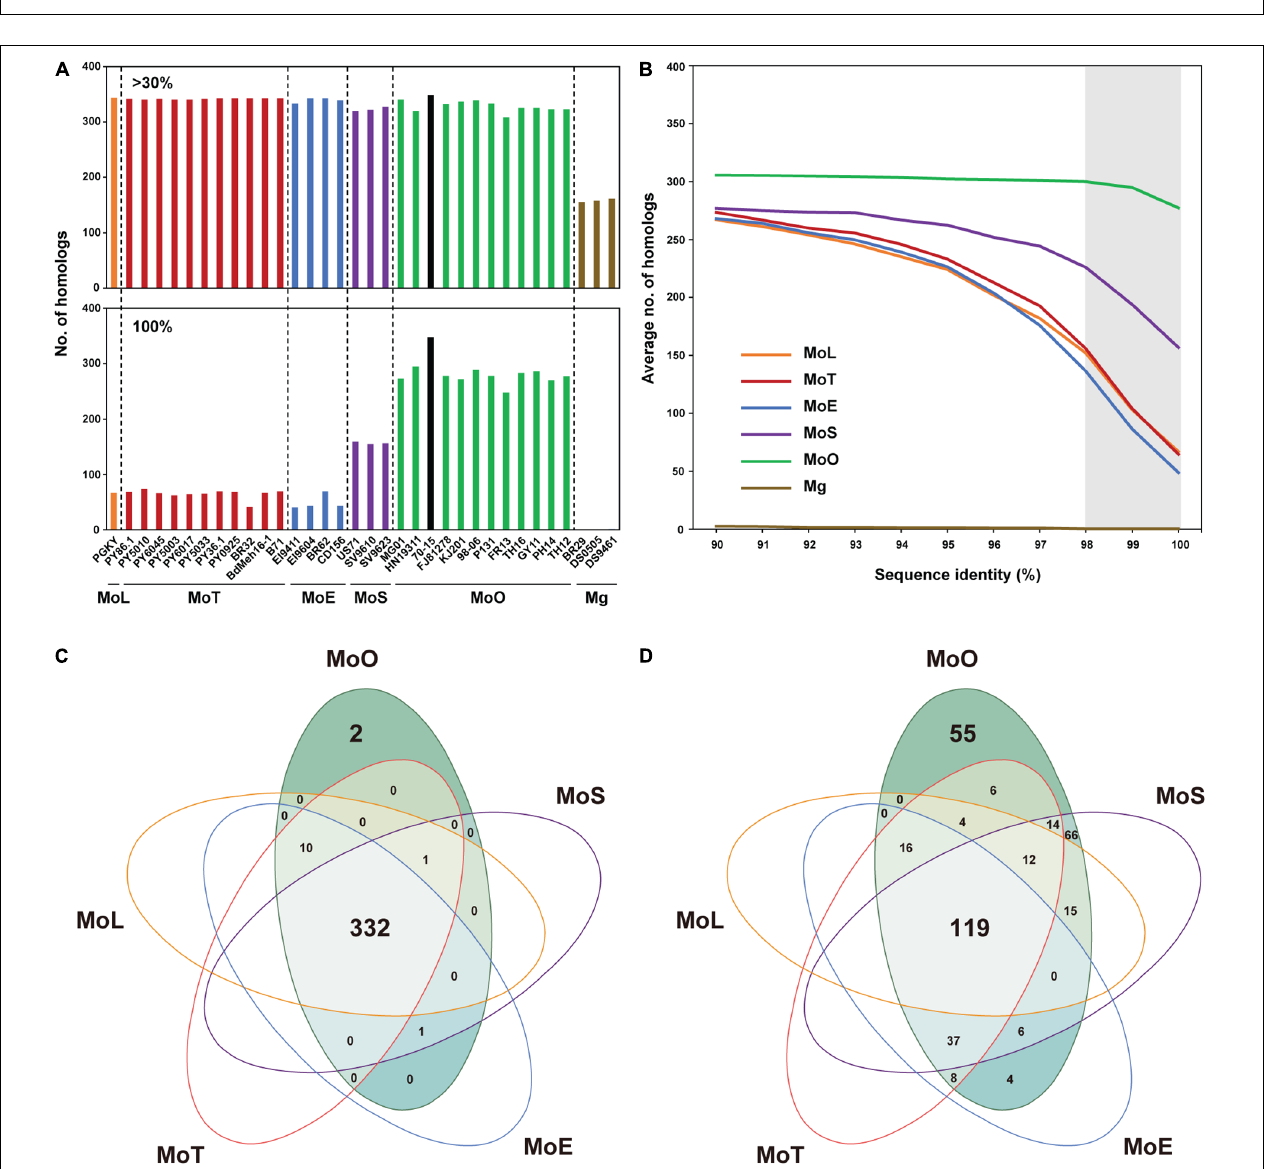
FIGURE 2 | Distribution pattern of the proteins homologous to the 70-15 EFCs. (A) The number of EFC proteins homologous to those encoded by strain 70-15 (black bar) in each Magnaporthe isolate, identified via Exonerate, is shown. Data collected using two levels of sequence identity ( > 30% and 100%) are presented. Each pathotype is color-coded: MoL (orange), MoT (red), MoE (blue), MoS (purple), MoO (green), and Mg (brown). (B) The average numbers of EFCs that exhibit 90–100% sequence identity to their homologs in 70-15 are shown. The gray shading indicates those that display 98–100% sequence identity. The number of EFC homologs shared among the pathotypes at the level of (C) 30% and (D) ≥ 98% sequence identity is noted. The list of EFCs in each set is noted in Supplementary Table 4 .